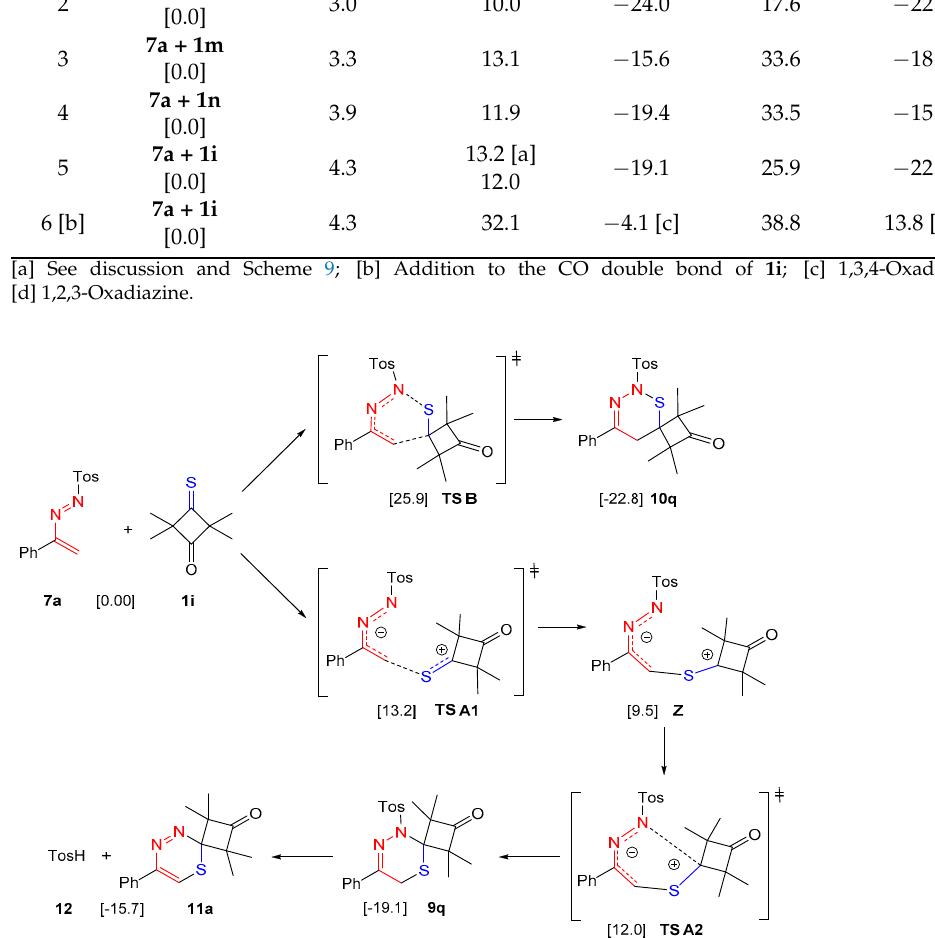
Scheme 9. Hypothetical cycloaddition of azoalkene 7a with sterically hindered thioketone 1i to 1,2,3- thiadiazine derivative 10q and step-wise reaction involving zwitterion Z leading to 1,3,4-thiadiazine derivative 9q and elimination to 2 H -1,3,4-thiadiazine 11a . (( ∆ G 298 ) in